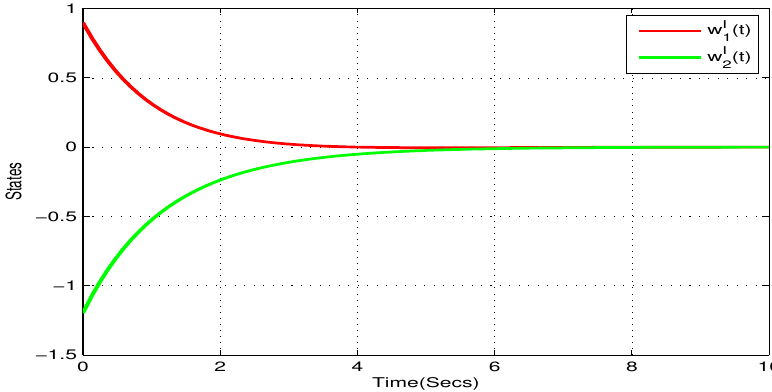
( t ) , w I ( t ) of systems (23) with state feedback control u 2 1